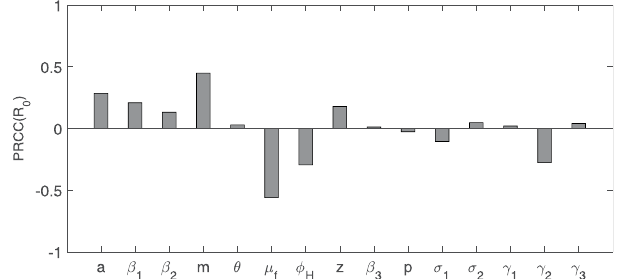
Figure 8. Partial rank correlation coefficients(PRCC) illustrating the dependence of basic reproduction number R 0 on each parameter.